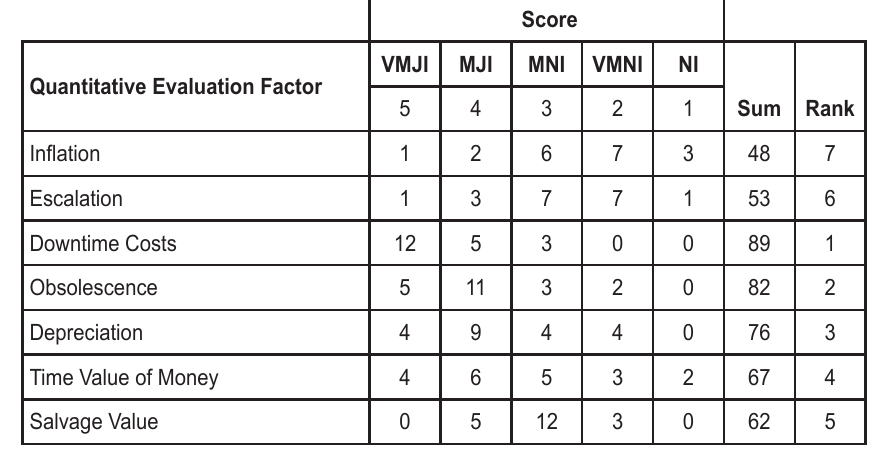
Table 3: Quantitative evaluation